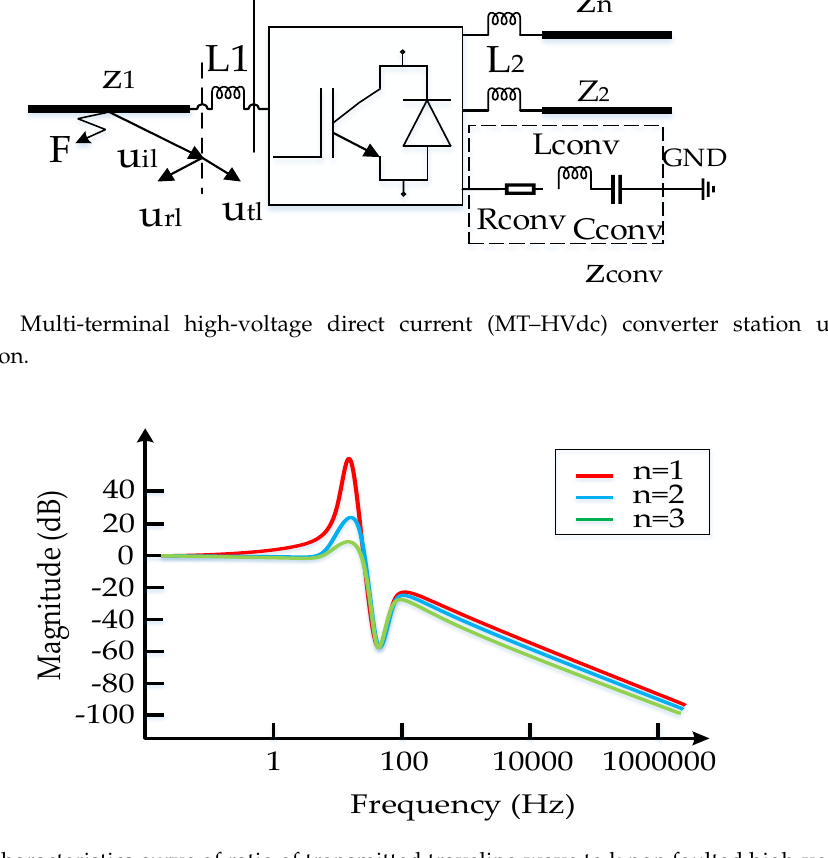
Figure 17. Characteristics curve of ratio of transmitted traveling wave to k non faulted high-voltage direct current (HVdc) lines and transmitted traveling wave to faulted HVdc line.